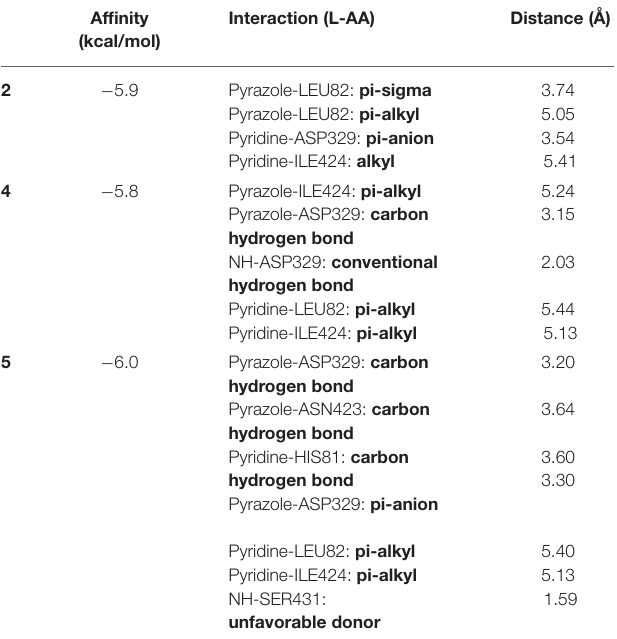
TABLE 9 | The binding interactions between the best-studied ligands and the Fophy protein selected active site. Affinity Interaction (L-AA) Distance (Å) (kcal/mol)